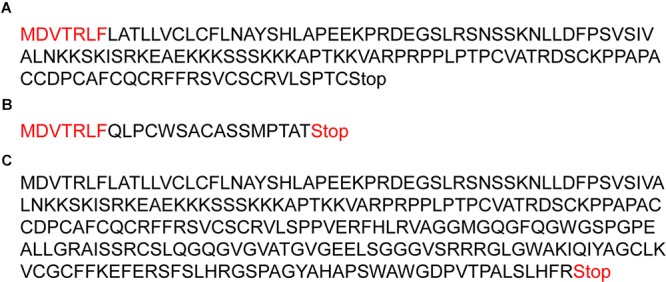
The effect of frameshift mutations on ASIP polypeptide. (A) Normal ASIP polypeptide with 133 amino acids and stop at codon 134; (B) Truncated ASIP protein with 24 amino acids and stop at codon 25 due to frameshift mutation in exon 2; (C) Abnormally long polypeptide with 253 amino acids due to a frameshift mutation in exon 4. Amino acids in red font in (A,B) are before frameshift and, thus shared between the normal and truncated ASIP.